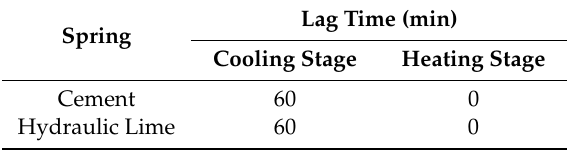
Table 4. Lag time between the maximum and minimum temperatures in spring climate.